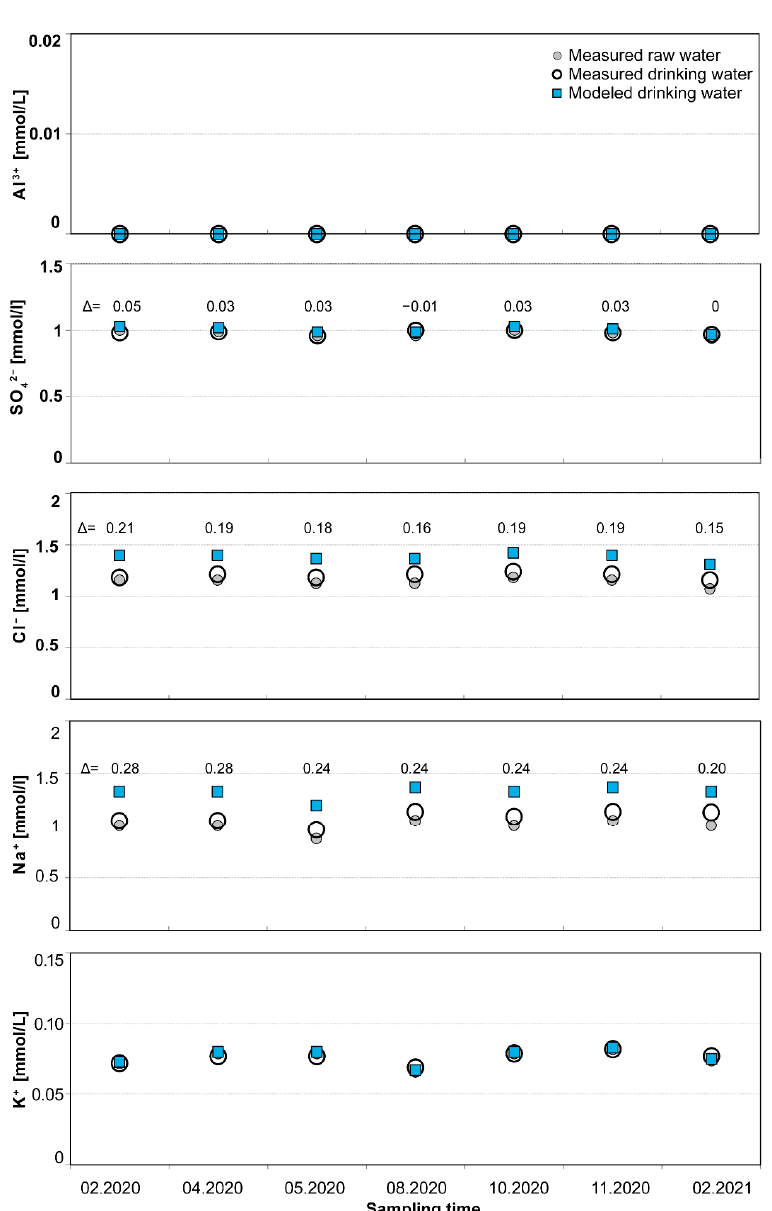
Figure 6. Comparison of the modeled values with the measured values of relevant parameters to reactants; Δ = modeled value of the parameter − measured value of the parameter.